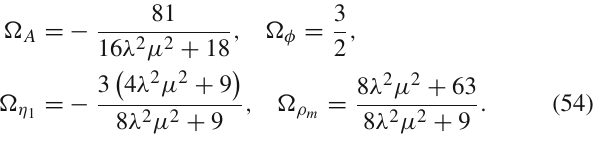
Fig. 2 On the left panel, the graph a shows the stability of the F ( A ) critical point. The stable critical points lie in the blue shaded region while non-shaded region is forbidden for critical points. On the right